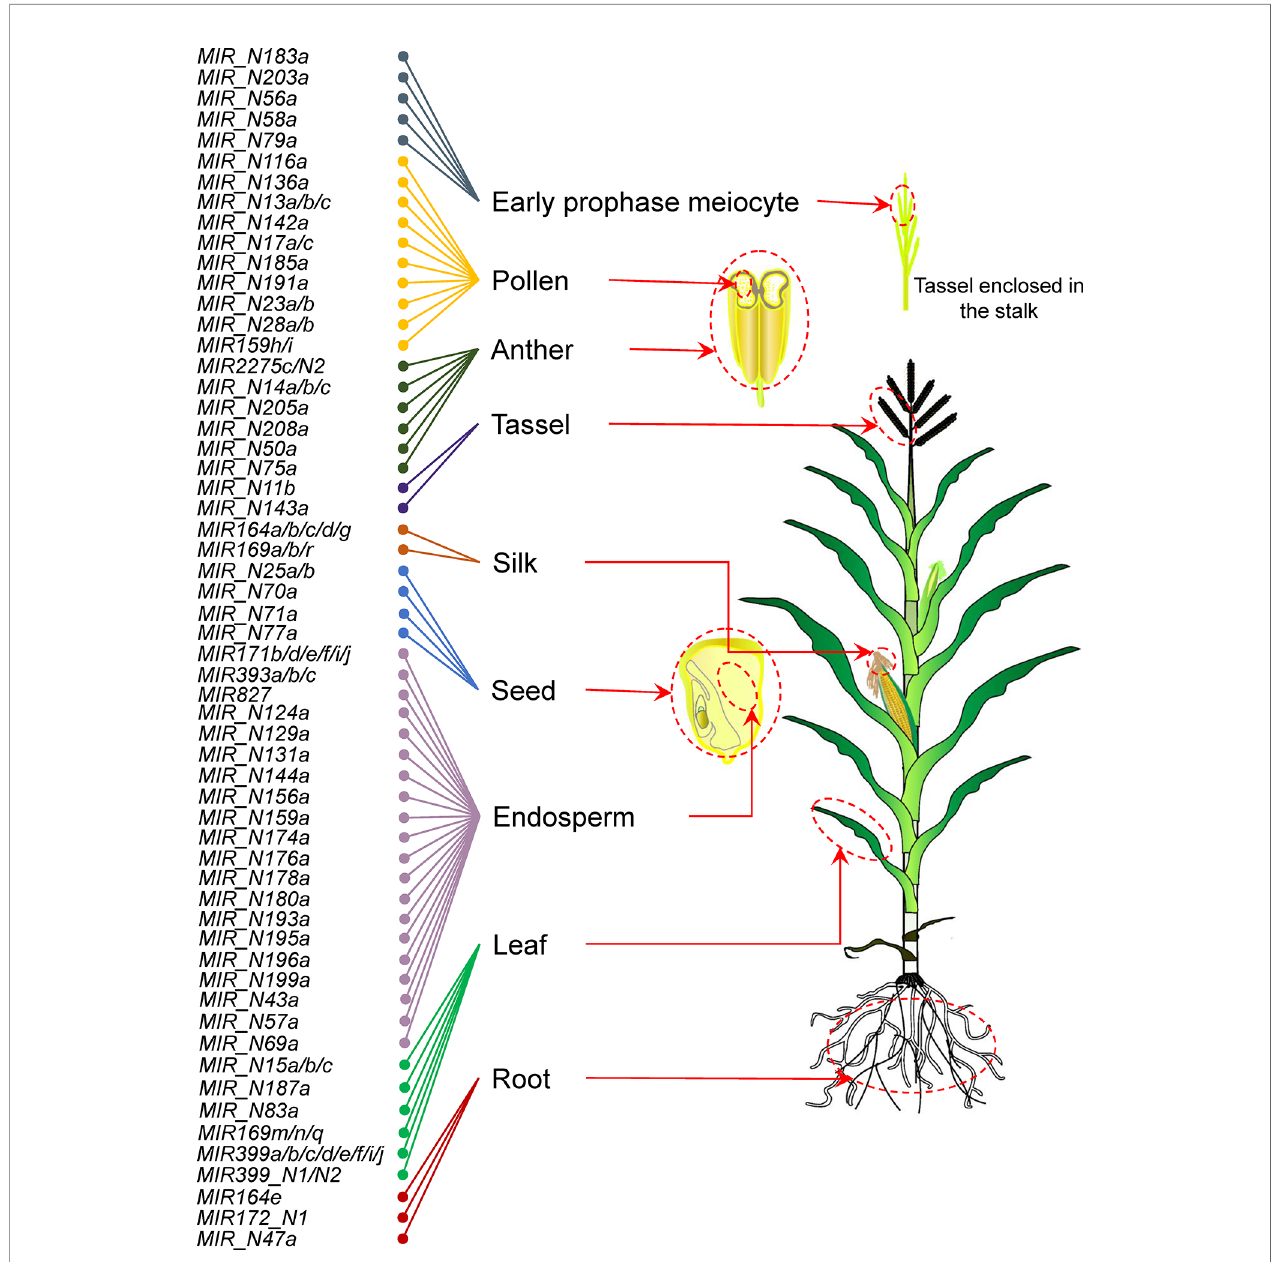
FIGURE 3 | Overview of tissue-speci fi c patterns of maize miRNA